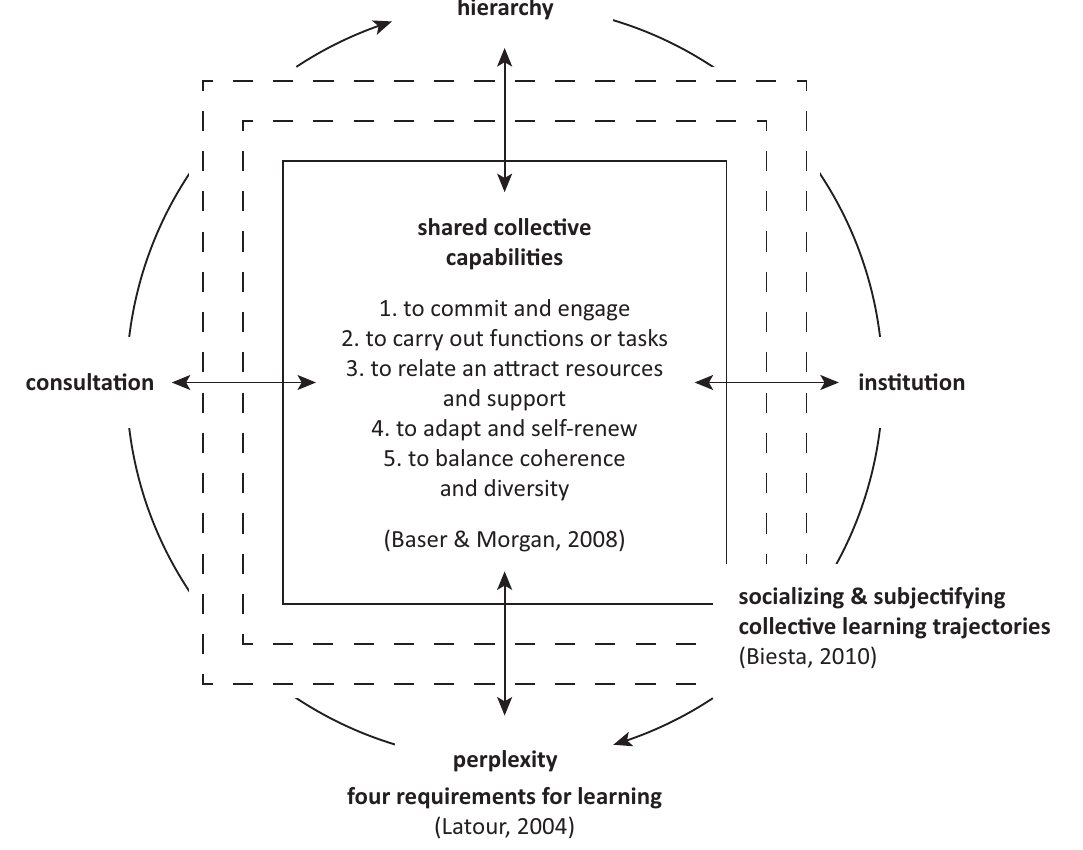
Figure 1. A conceptual framework for a situated understanding of collective